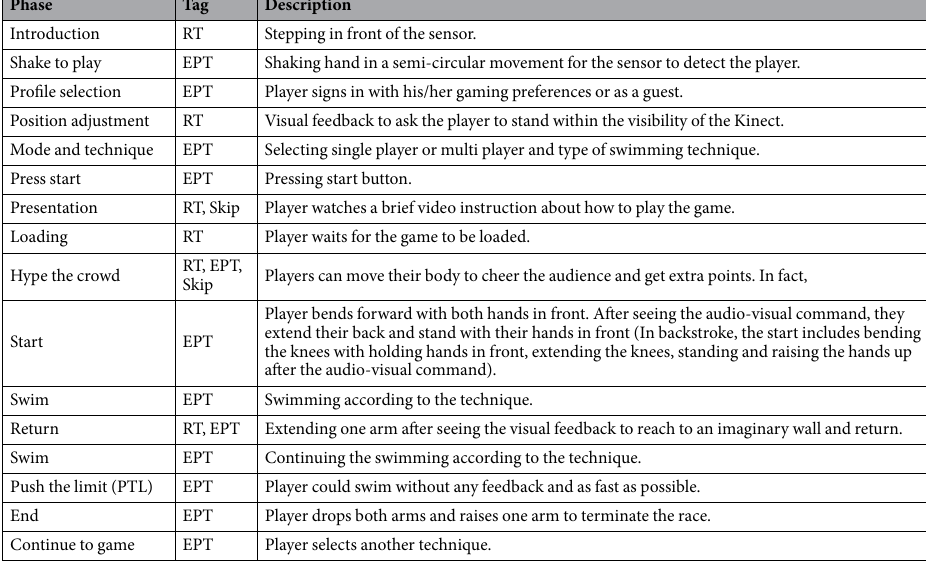
Table 2. Coding front crawl technique during swimming exergame for notational analysis. EPT: effective playing time; RT: resting time; Skip: the player has the options to rest, play, or skip this part using auditory